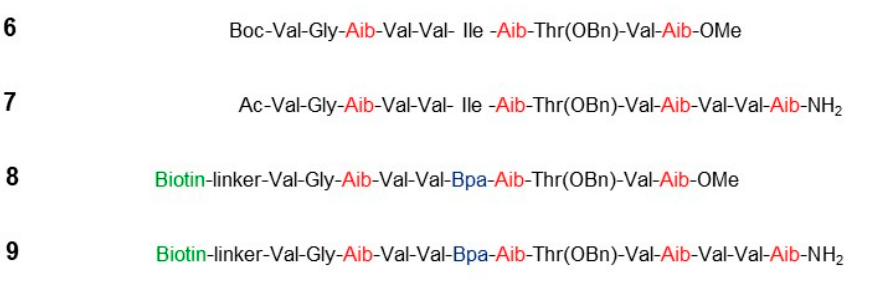
Figure 6. Representative helical peptide inhibitors (HPIs) and affinity labeling reagents for γ -secretase. Each depicted HPI is a D -peptide. Helix-inducing aminoisobutyric acid (Aib) residues are highlighted in red. Photoreactive 4-benzoyl- D -phenylalanine residues are blue, and linker-biotin moieties are in green.